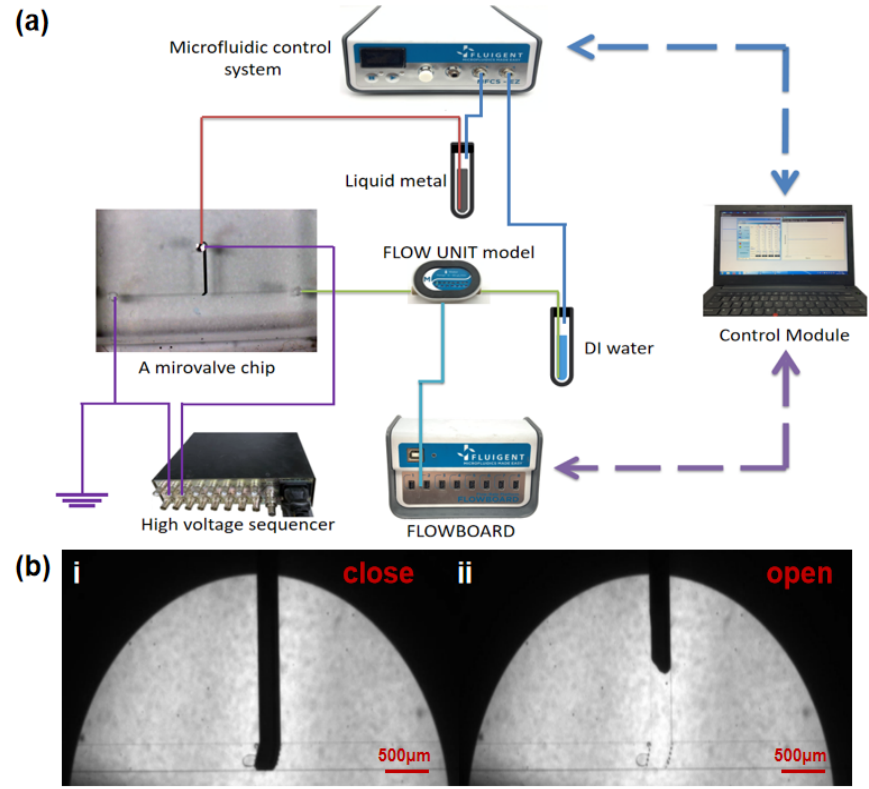
Figure 2. The control and flow detection platform of a microvalve and a valve switch diagram. ( a ) A computer works as a control module connected to a four-channel microfluidic control system (for pumping the liquid metal and Di water into the microchannels), and a flow rate platform (includes a FLOWBOARD and a FLOW UNIT model) to detect the flow rate of Di water. A high voltage sequencer is used to apply cathodic protection: the liquid metal inlet is connected to the cathode, and the anode is connected to the Di water outlet and grounded separately. ( b ) The close ( i ) and open ( ii ) state of the microvalve observed by a microscope.